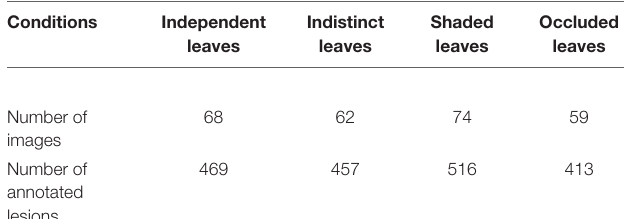
TABLE 1 | Detailed information of samples in test